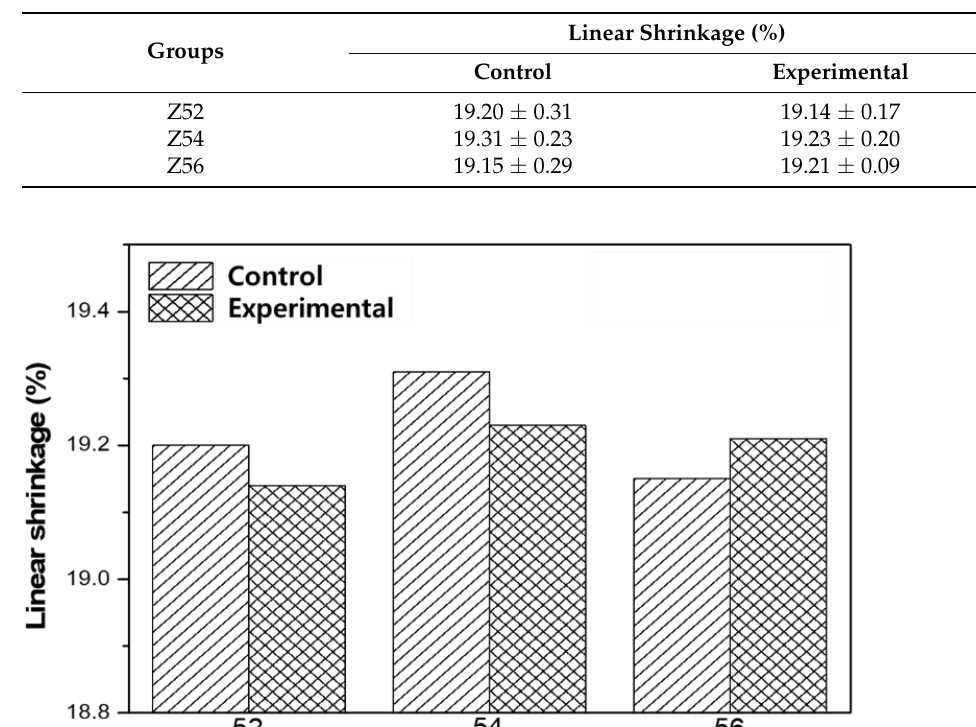
Figure 5. Comparison of linear shrinkage between control and experimental groups after final sintering.